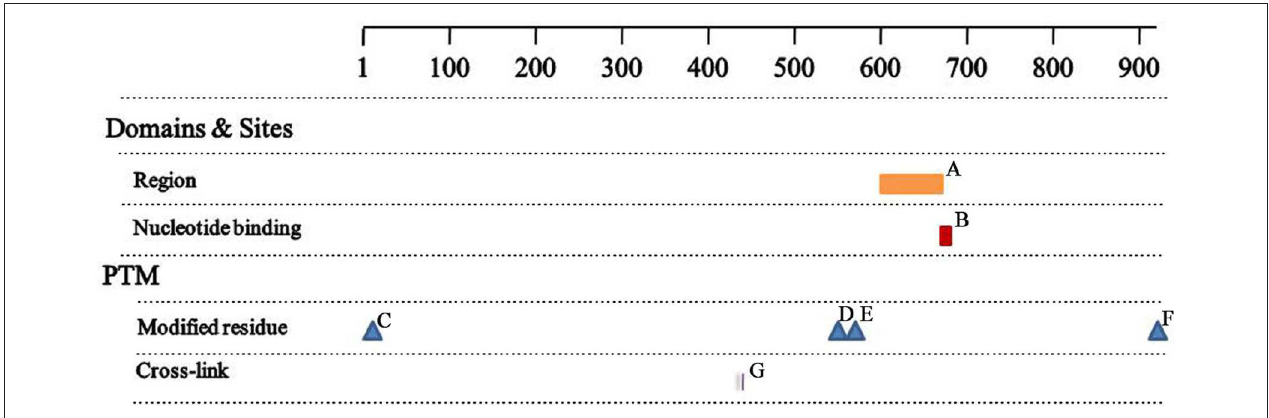
FIGURE 4 | Analysis of the mutant proteins (A) Region 601-671, interaction with EXO1; (B) NP_BIND 669-676, ATP; (C) MOD_RES 2-2, N-acetylalanine; (D) MOD_RES 555-555, N6_acetyllysine; (E) MOD_RES 567-567, N6_acetyllysine; (F) MOD_RES 921-921, phosphoserine; (G) CROSSLINK 430-430, Glycyl lysine isopeptide (Lys-Gly) (interchain with G-Cter in